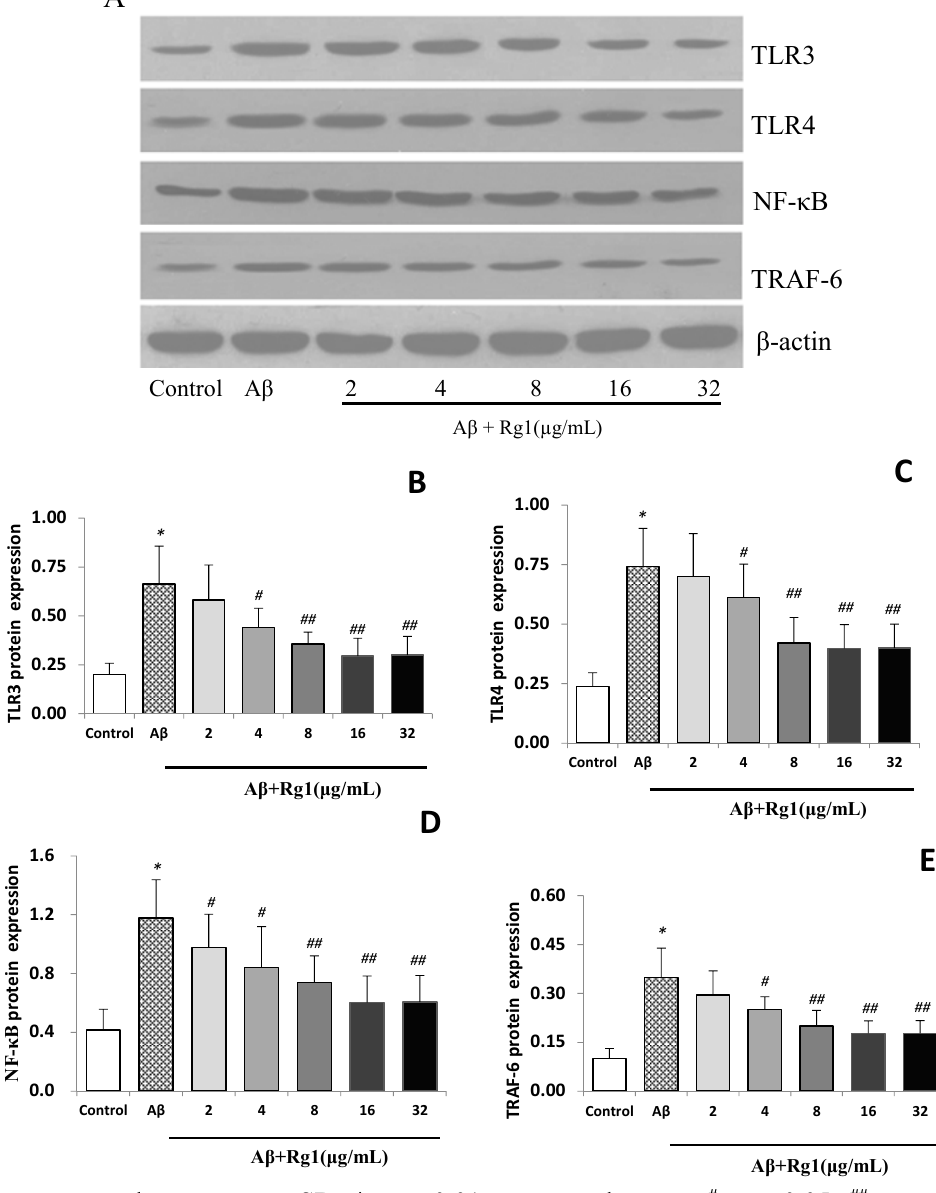
Figure 2. ( A ) Effect of ginsenoside Rg1 on the protein expression of TLR3, TLR4, NF- κ B and TRAF-6 (pictures of western-blots); ( B ) effect of ginsenoside Rg1 on the protein expression of TLR3; ( C ) effect of ginsenoside Rg1 on the protein expression of TLR4; ( D ) effect of ginsenoside Rg1 on the protein expression of NF- κ B; ( E ) effect of ginsenoside rg1 on the protein expression of